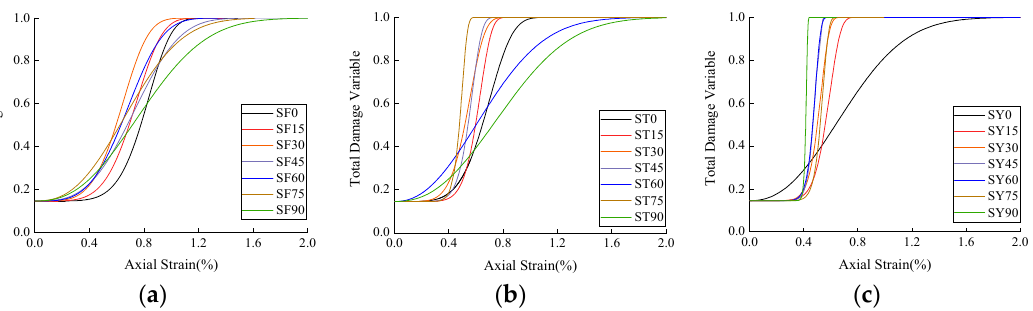
Figure 15. Loaded damage evolution curves of the multi-shape fractured samples: ( a ) single fracture samples, ( b ) T-shaped fracture samples, and ( c ) Y-shaped fracture samples.